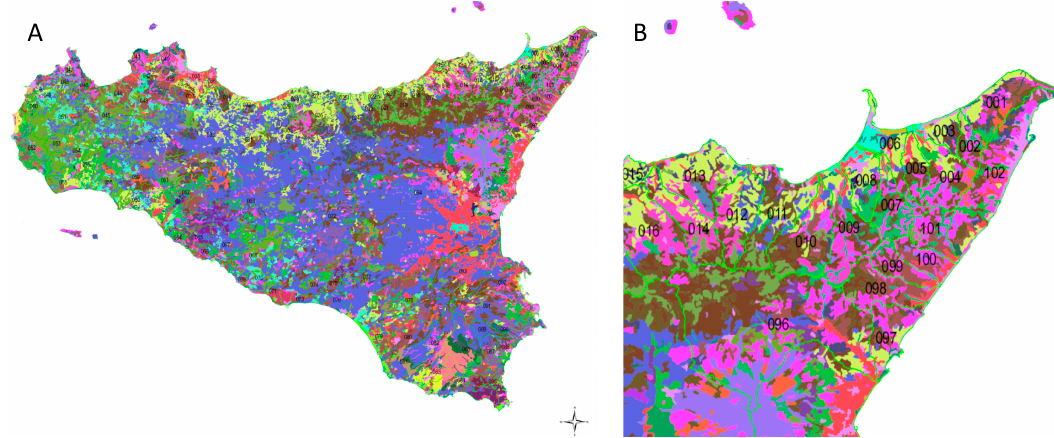
Figure 9. Land uses in Sicily ( A ) and in the Fiumedinisi river basin area ( B ).